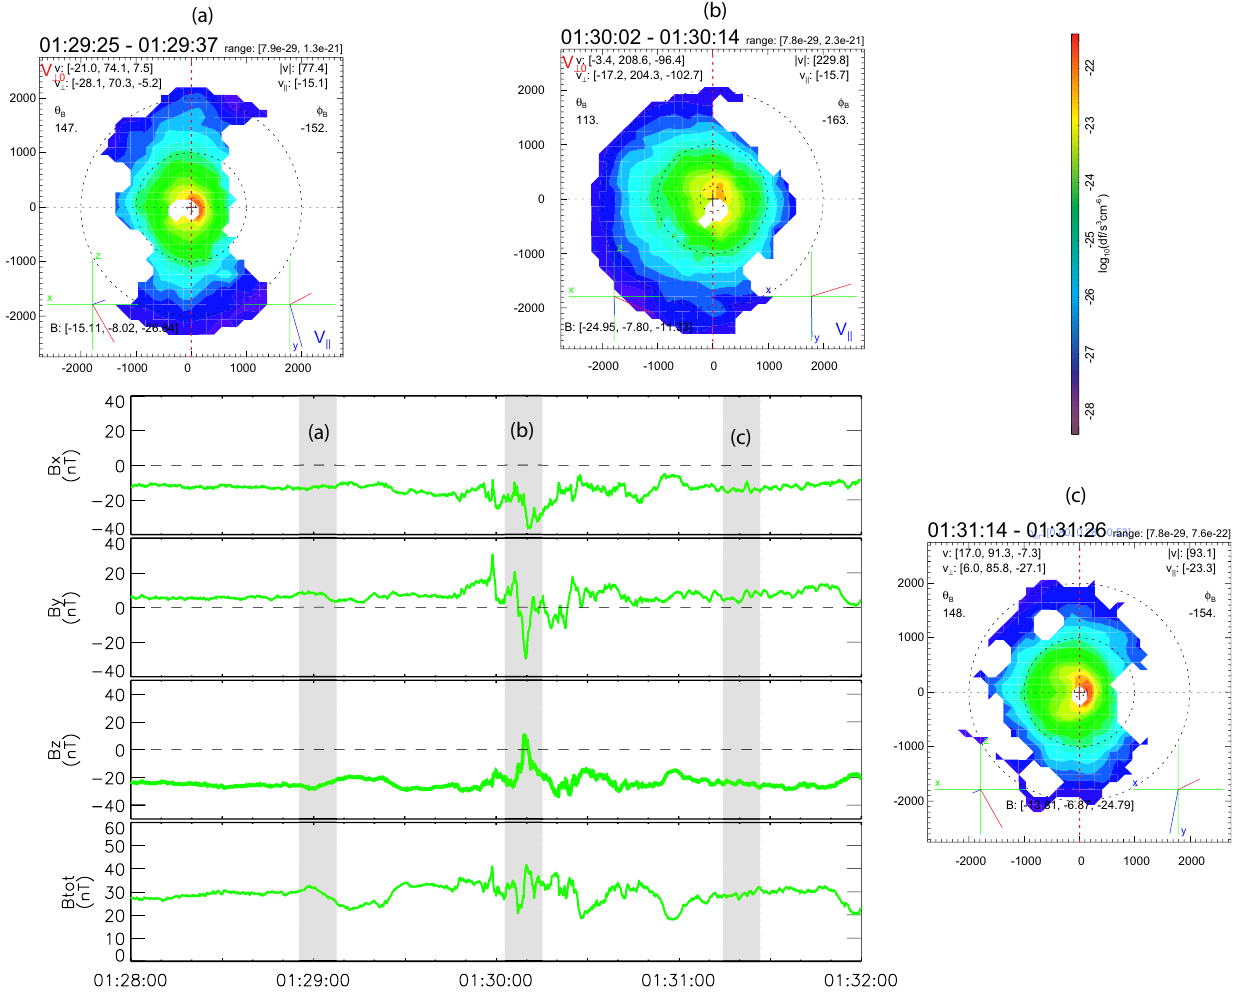
Fig. 12. Ion velocity distribution from HIA during the same interval as shown in Fig. 10, which is of the first type of boundary crossing. The resolution of these distributions is 12s. The starting time of each distribution is indicated in the magnetic field